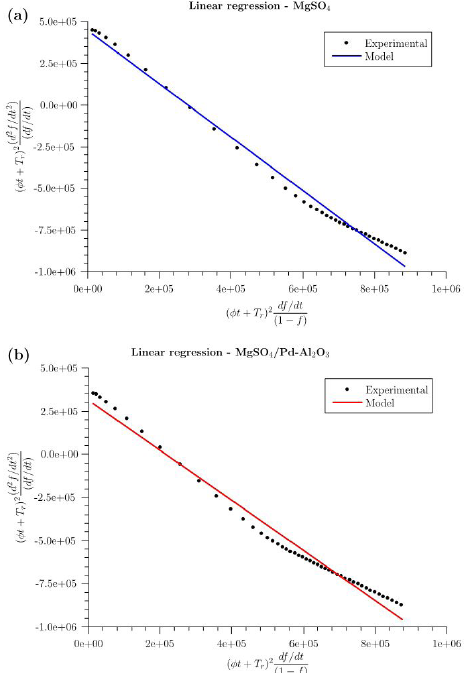
O material: (a) secondary electrons 2 3